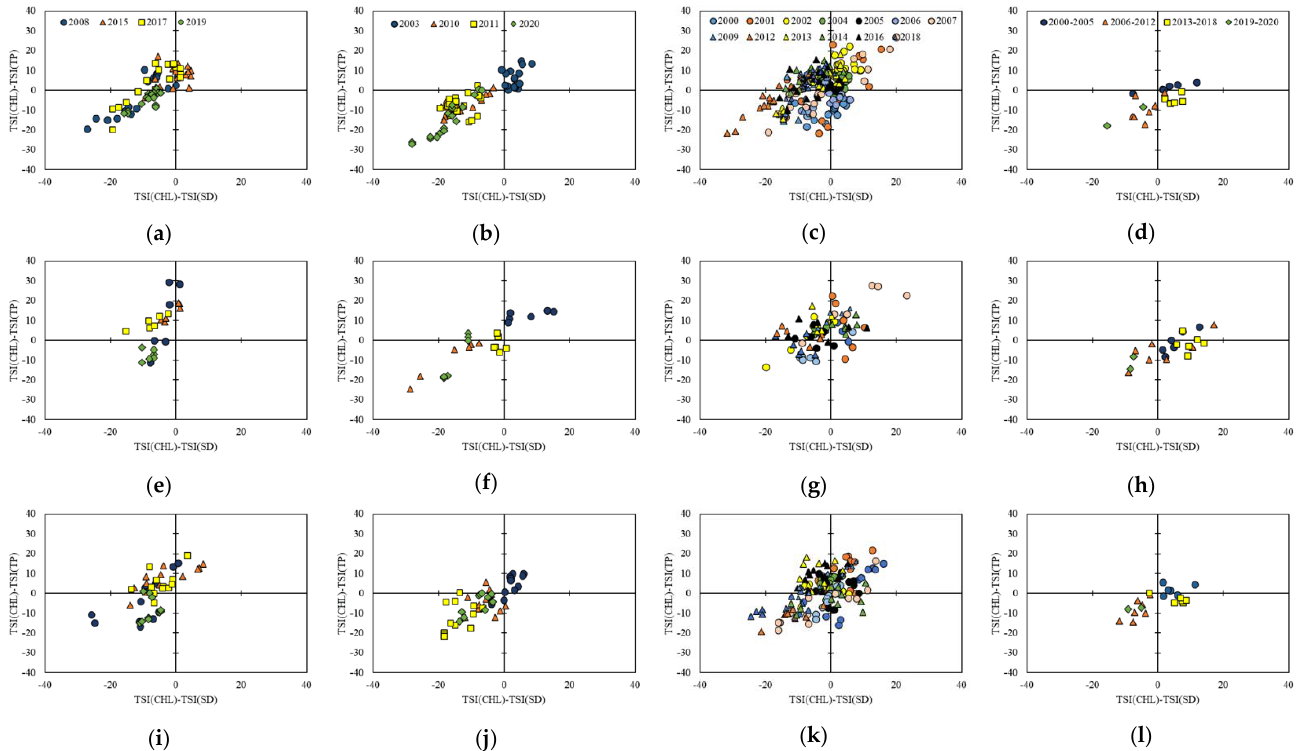
Figure 7. Variations in the trophic state index deviation (TSID): ( a – d ) represent the TSID in the pre-monsoon period of the drought, flood, and monsoon years, and the annual average values of the study period, respectively; while ( d – h ) show the monsoon period and ( i – l ) show the post-monsoon period using the same year group sequence as in ( a – d ).